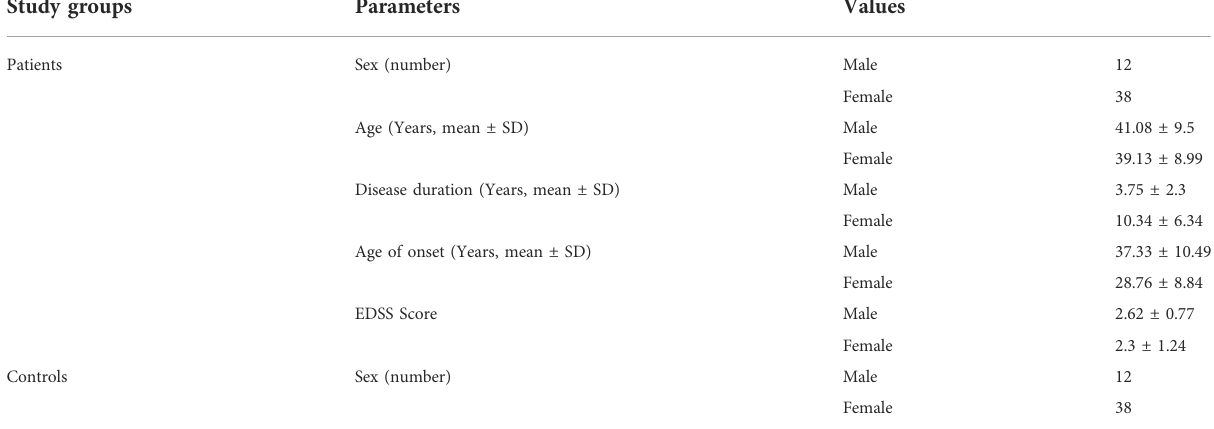
TABLE 1 General parameters of study participants. Study